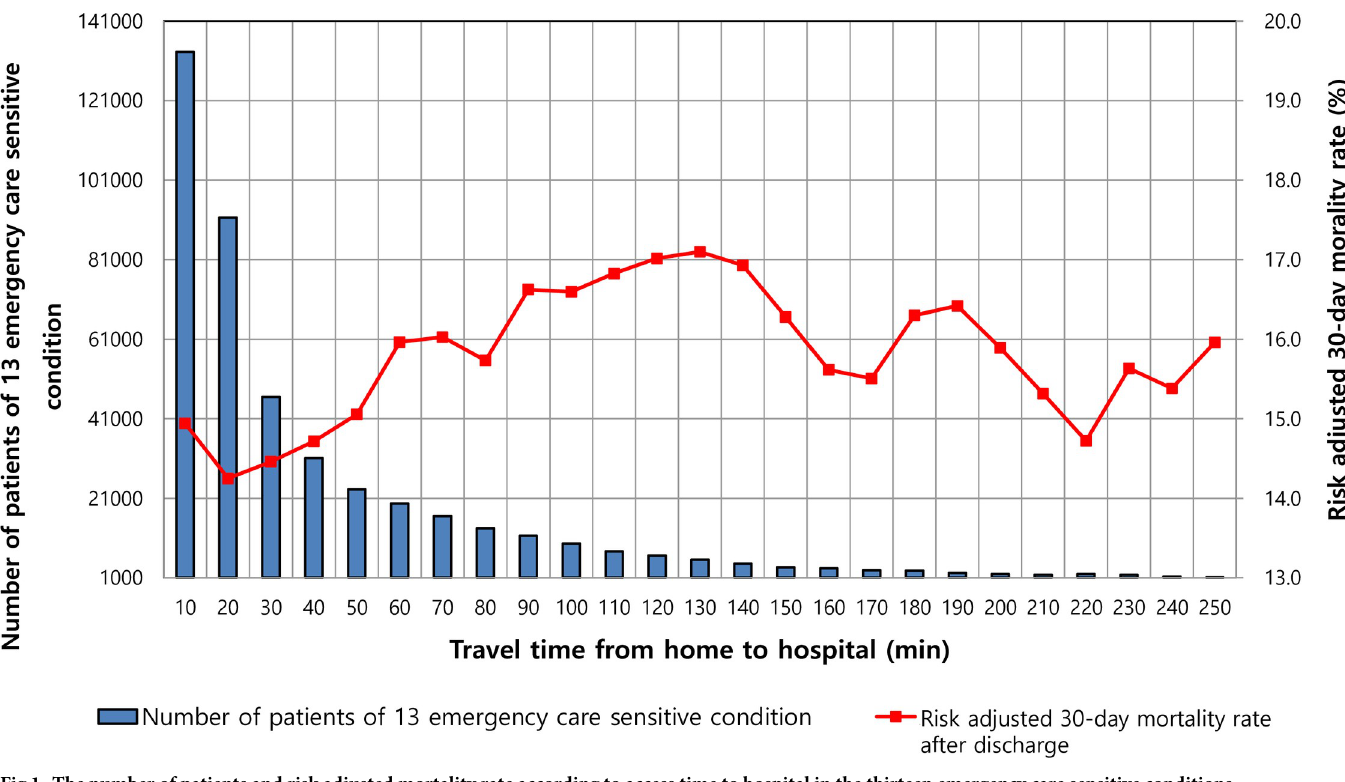
Fig 1. The number of patients and risk adjusted mortality rate according to access time to hospital in the thirteen emergency care sensitive conditions.